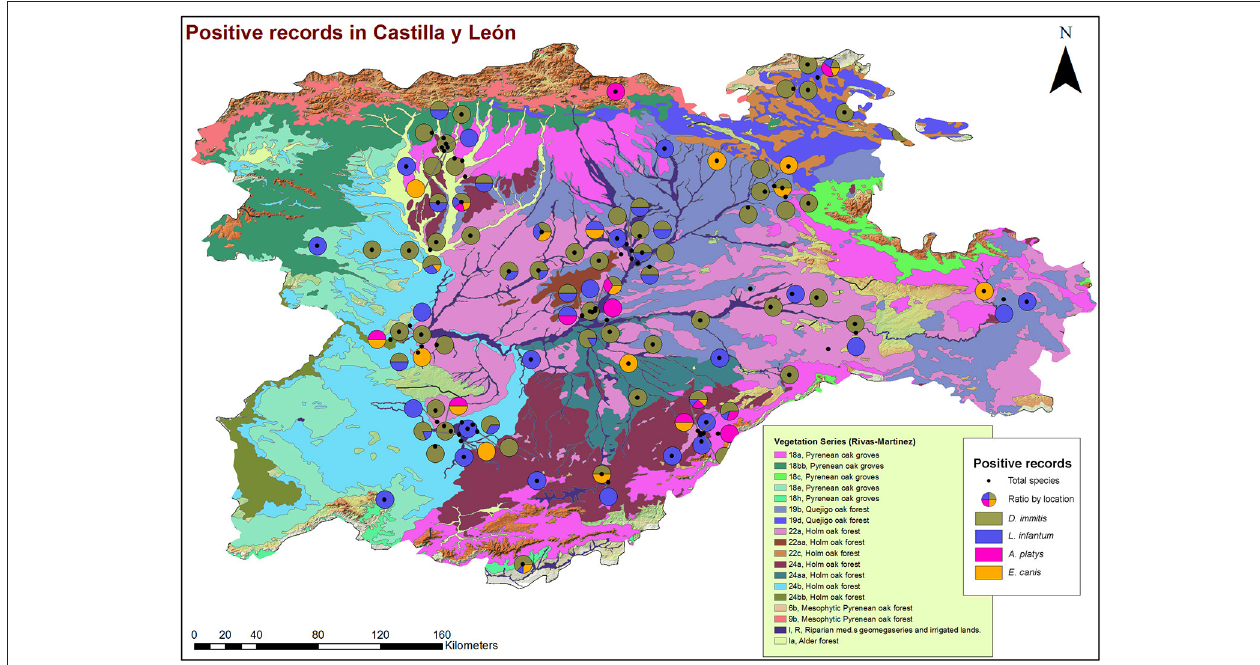
FIGURE 4 | Location of phytoclimatic series and geolocation of dogs infected by D. immitis ( ), and seroprevalences for L. infantum ( ), A. platys ( ), and E. canis ( ) in the nine provinces of Castilla y León,